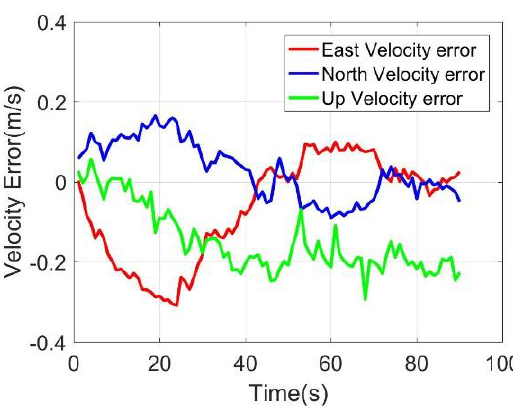
Figure 13. Positioning errors.